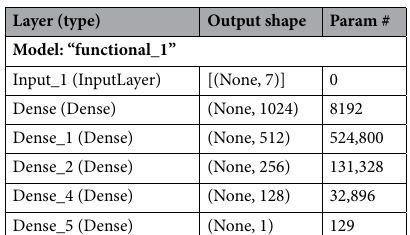
Table 2. The deep neural network (DNN) that includes 7 inputs, 1 target, and 1024, 512, 256, 128, 128 neurons with 5 layers. Total params: 697,345. Trainable params: 697,345. Non-trainable params: 0